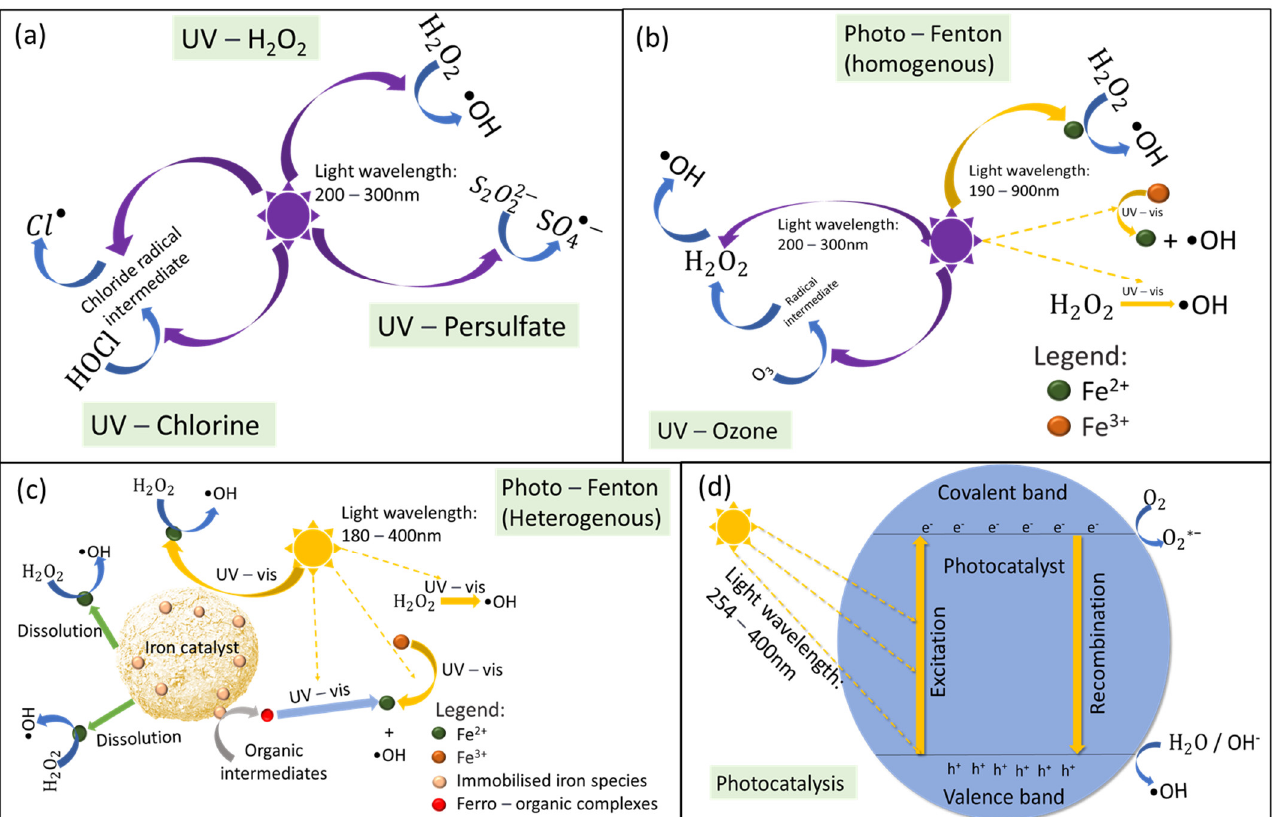
Figure 2. Graphical illustration of the reaction mechanisms for various light-driven processes: UV/oxidant ( a ), UV/ozone and photo-Fenton (homogenous) ( b ), photo-Fenton (heterogenous) ( c ), photocatalyst ( d ).